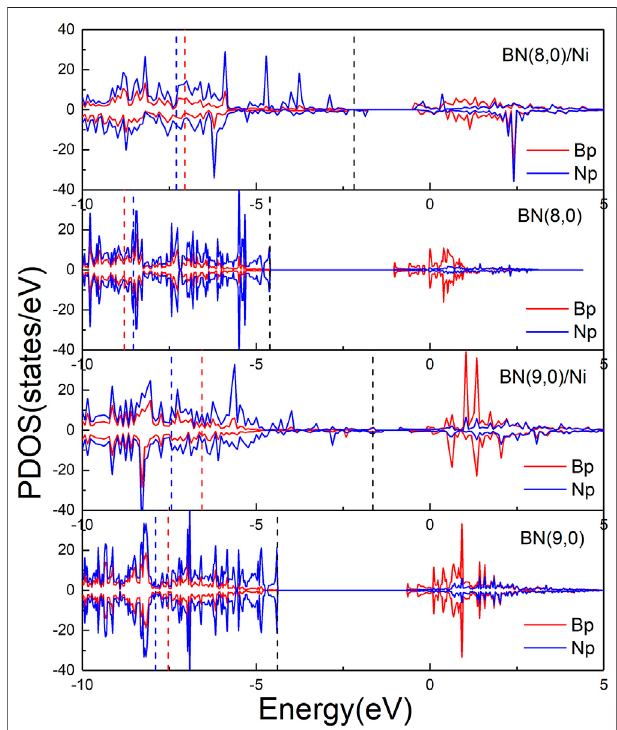
FIGURE 5 | Partial density of states of B (red) and N (blue) p orbitals of BN(8.0)/Ni, BN(8.0), BN(9.0)/Ni, and BN(9.0). The black dashed line is the Fermi level of each species. The red and blue dashed lines are the p band center of each